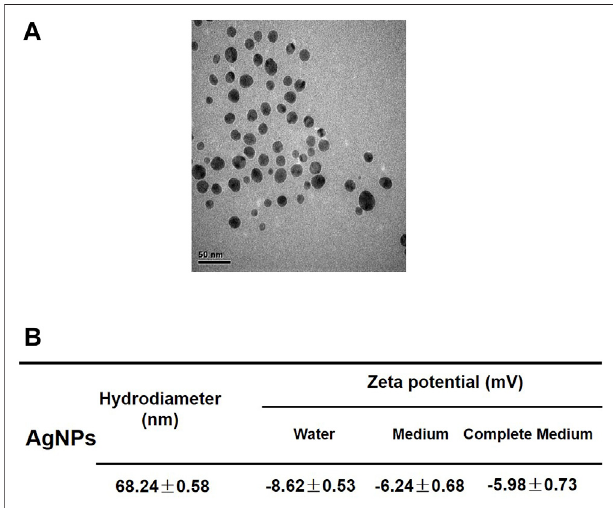
FIGURE 1 | Characterization of silver nanoparticles. (A) Representative TEM image of AgNPs applied in this study. The scale bar is 50 nm. (B) Hydrodynamic diameter and zeta potentials of 4 μ g/ml AgNPs in water, serum-free medium and complete culture medium.